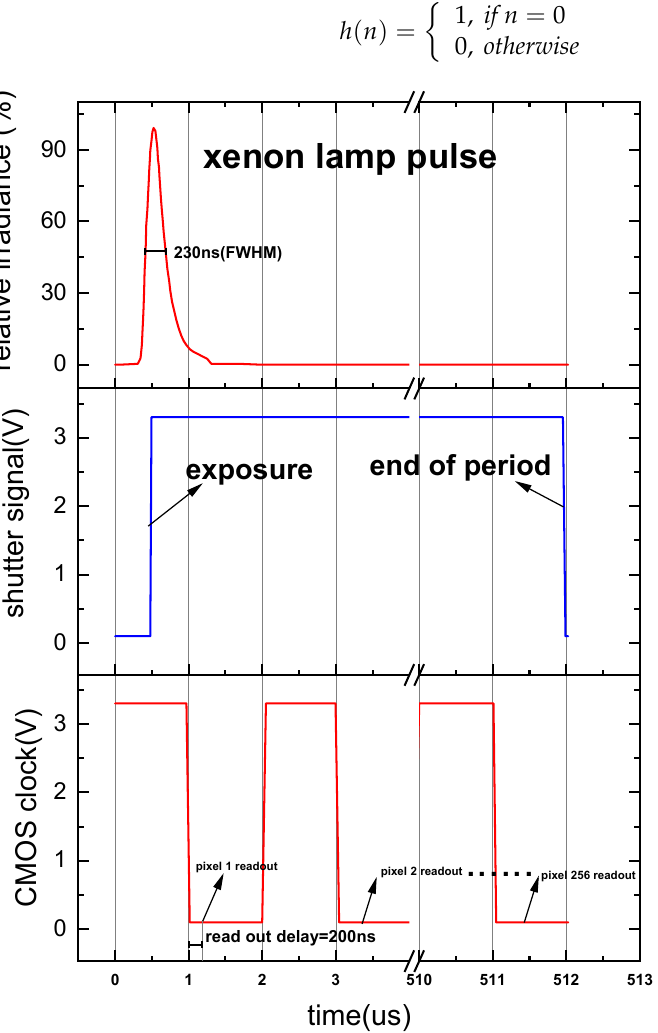
Figure 2. Timing schematic of the working procedure showing how the CMOS image sensor captures the xenon flash.